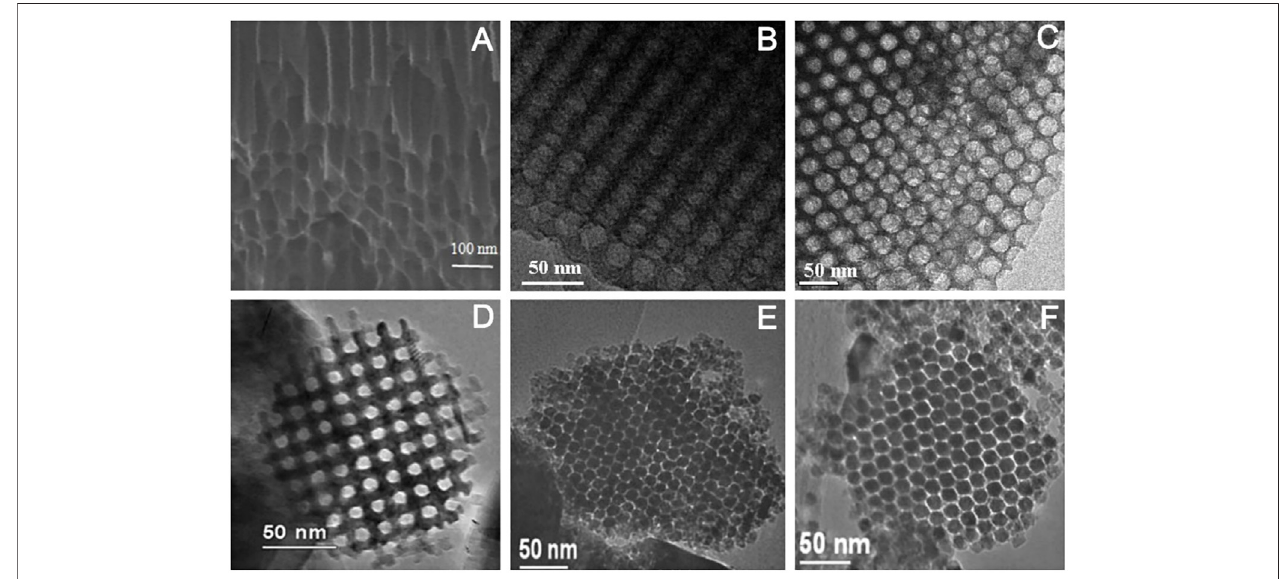
FIGURE 10 | SEM images of s of CNTs arrays/NPAA composite membrane (A) (Mohajeri et al., 2017); TEM images of C-FDU-18-800 (B) and Si-FDU-18-HC (C) (Deng et al., 2007); Cr 2 O 3 (D), (Jiao et al., 2005), In 2 O 3 (E), and Co 3 O 4 (F) (Yue and Zhou, 2007).